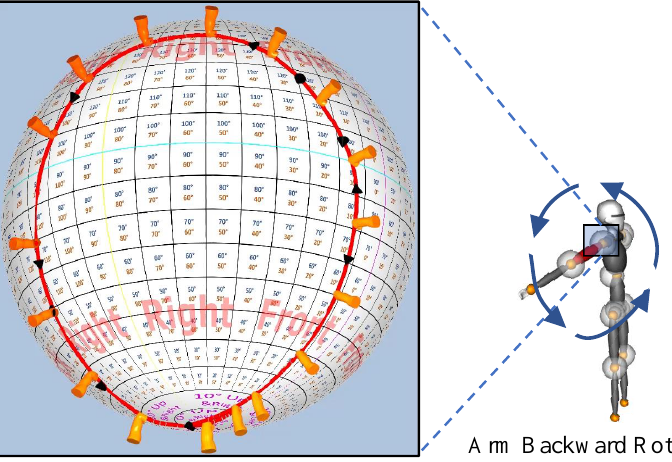
Figure 7. Visualization of right upper arm ( b 2 ) movement for a rotational backward arm swing.